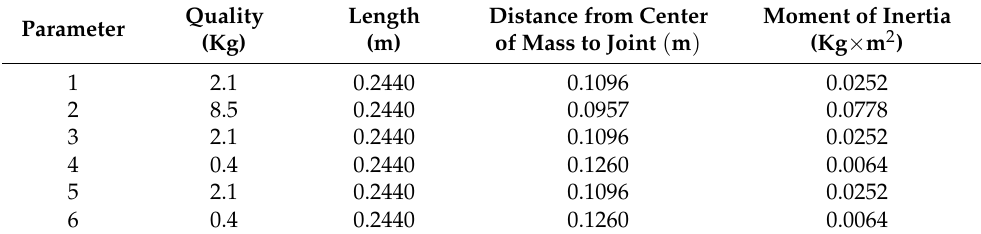
Table 2. The structure and dynamic parameters of the 4-DOF parallel robot.